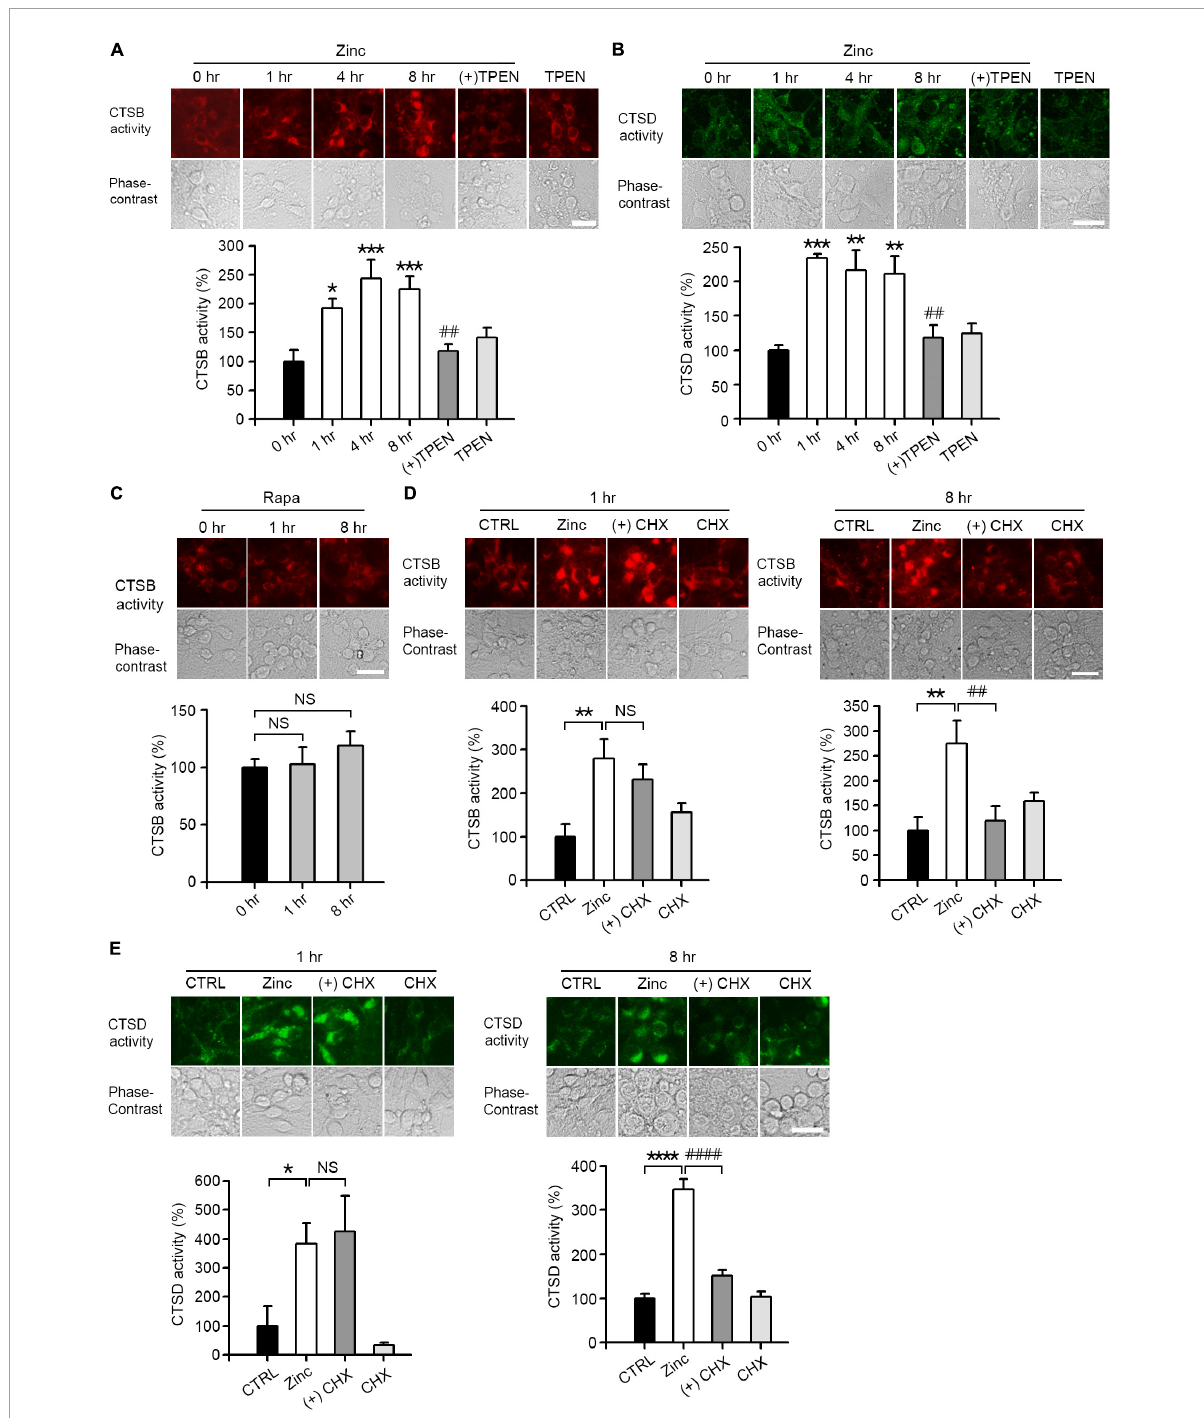
FIGURE4 Zinc increases CTSB and CTSD activity. (A,B) In situ enzyme activity analysis for CTSB (A) and CTSD (B) in mouse near-pure cerebrocortical neuronal cultures. The fluorescence signal of the cleaved substrates of CTSB or CTSD was observed at the indicated time points after exposure to 25 µ M ZnCl 2 (Zinc) with or without 500 nM TPEN (+TPEN) or TPEN alone. The bar graph represents quantitative analysis of the fluorescence intensity (mean ± SEM, n ≥ 5 different fields taken from ≥ 4 independent biological replicate experiments). Scale bar: 25 µ m, * p < 0.05, ** p < 0.01 or *** p < 0.001, and ## p < 0.01 vs. zinc (8 h) by ANOVA with post hoc Dunnett’s test. (C) In situ enzyme activity analysis for CTSB in mouse near-pure cerebrocortical neuronal cultures. The fluorescence signal of the cleaved substrates of CTSB was